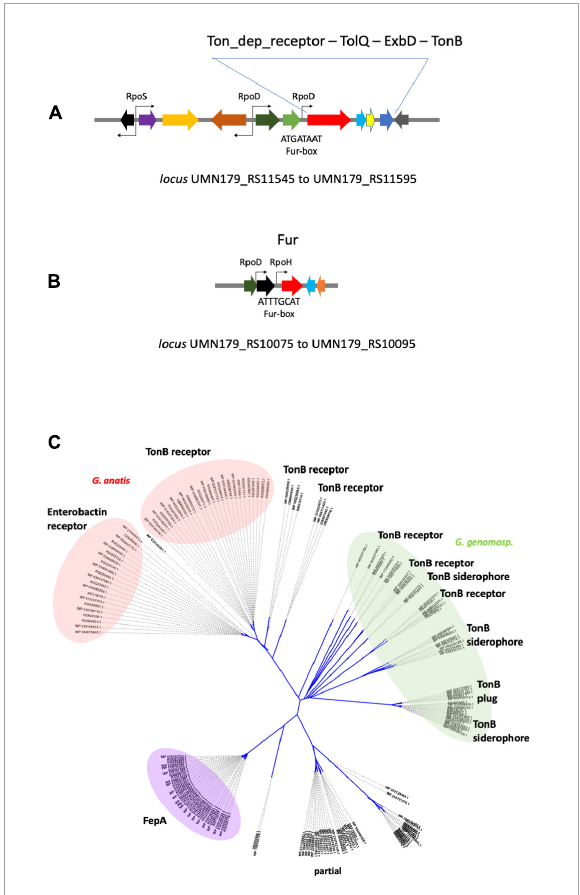
FIGURE9 TonB-dependent receptors in Gallibacterium sp. (A) Map of the locus harboring the TonB-dependent receptor gene (FepAG) from G. anatis UMN179 chromosome. Gene encoding FepAG (boxed red arrow) is homologous to the enterobactin receptor gene ( erf77464.1 ) and seems to be part of a four- members operon. The promoter nearest to fepAG was predicted as a RpoD-dependent promoter, indicated as RpoD above the tinny black arrow; a Fur-box with its consensus sequence was in the same intergenic region as indicated below the gray line. (B) Map of the locus encompassing the fur gene (red boxed arrow) in G. anatis UMN179 chromosome. The two promoters predicted to be close to fur are indicated as tinny black arrows in the drawing; one would depend on RpoH and the other on RpoD. One or both could control the gene expression of fur ; below the proximal promoter, a Fur-box with its consensus sequence is indicated in the drawing. (C) Phylogeny of TonB-dependent receptors in the genus Gallibacterium sp. A total of 178 amino acid sequences were recovered from 41 sequenced genomes (GeneBank, Supplementary Information ), of these: G. anatis (31 strains), G. genomospecies (7 strains), and G. salpindigitis (3 strains). An unrooted tree was built with the data; the phylogram shows five clades of proteins phylogenetically related to TonB-dependent receptor proteins from G. anatis. The first clade containing the protein from G. anatis UMN179 was termed enterobactin receptor (left, pink) because of the homology of proteins with the transferrin receptor sequence from Shigella boidii (accession EFX6075140.1). Another protein group (right, pink) was termed TonB receptor originating from G. anatis 12656-12. The disperse group, highlighted in green, encloses the TonB-dependent receptor and the